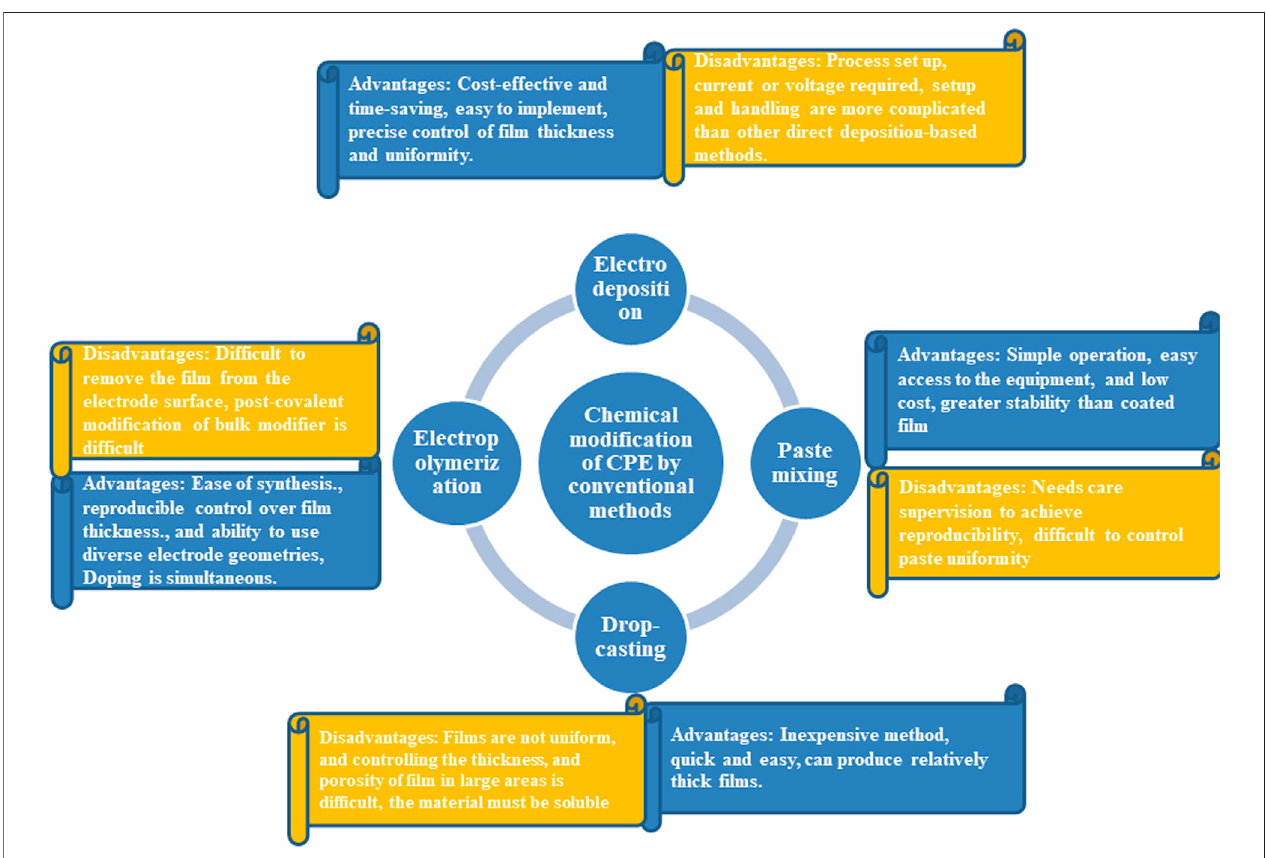
FIGURE 2 | Different types of methods used for modi fi cations on CPE.